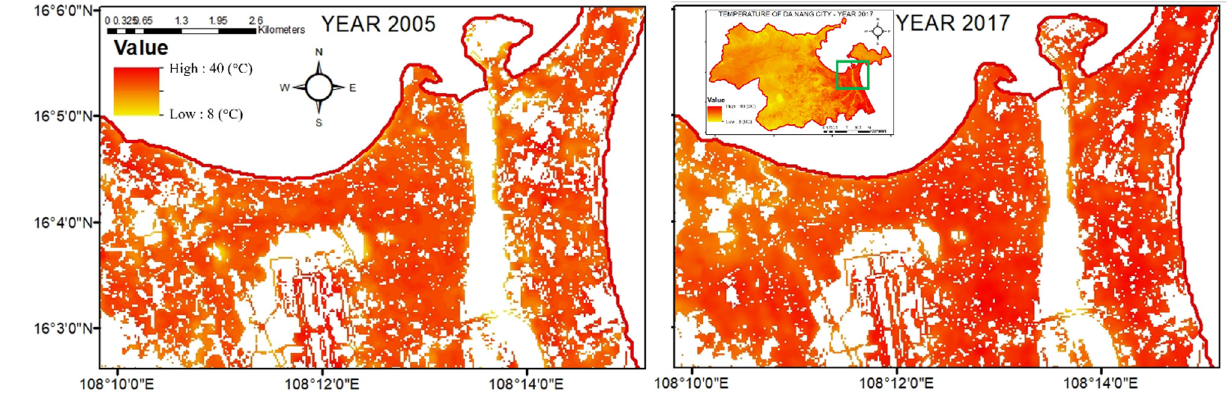
Figure 12. The spatial temperature distribution of Da Nang city and Quang Nam province in 2005 and 2017.